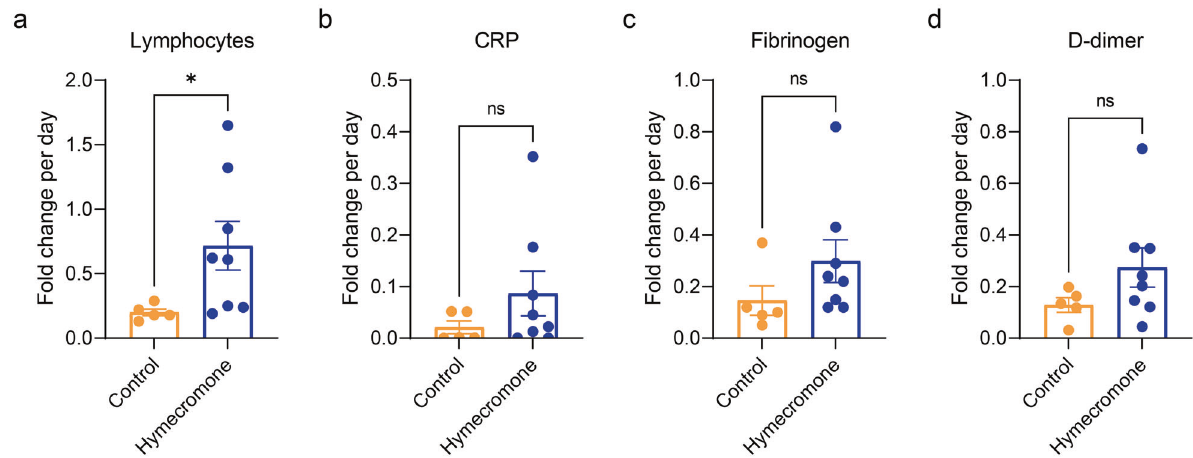
Fig. 8 Hymecromone accelerate the recovery of COVID-19 patients from lymphocytopenia. Changes in lymphocytes ( a ), CRP ( b ), fi brinogen ( c ), and D-dimer ( d ) were calculated as the fold change of diverse clinical indicators per day in patients with lymphocytopenia. Data are presented by mean ± SEM. The signi fi cant difference was con fi rmed by the Mann – Whitney test. * P < 0.05; ** P < 0.01; *** P < 0.001; **** P < 0.0001; ns, not signi fi